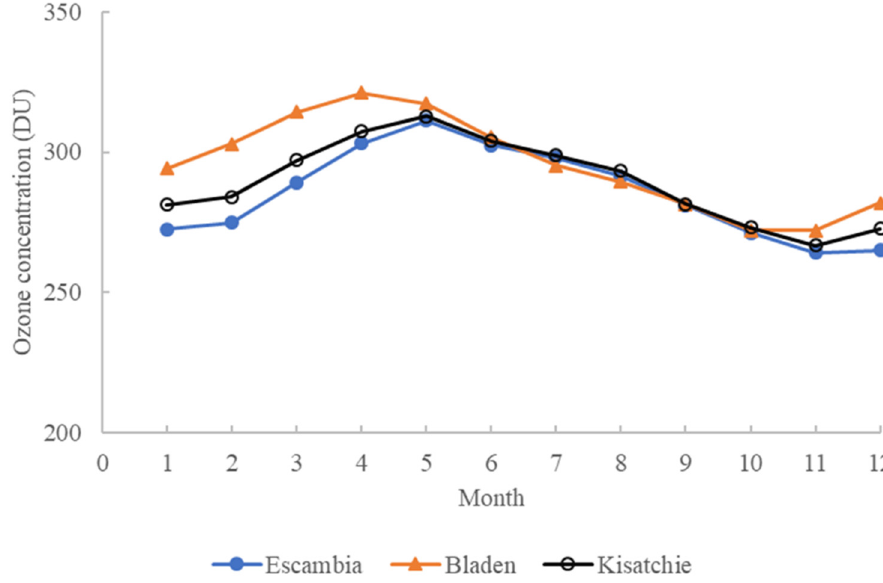
Figure 5. The integrated monthly average of total column ozone in the three areas.